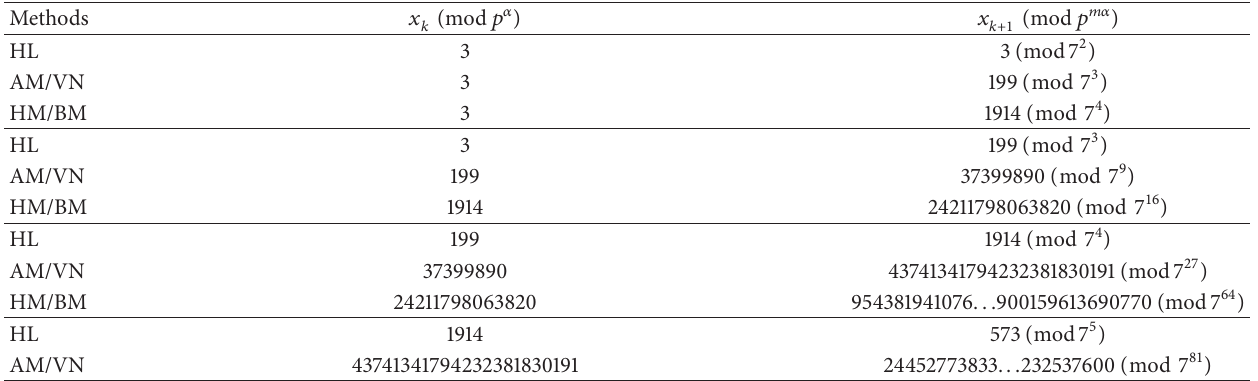
Table 1: Comparison of HL, AM/VN, and